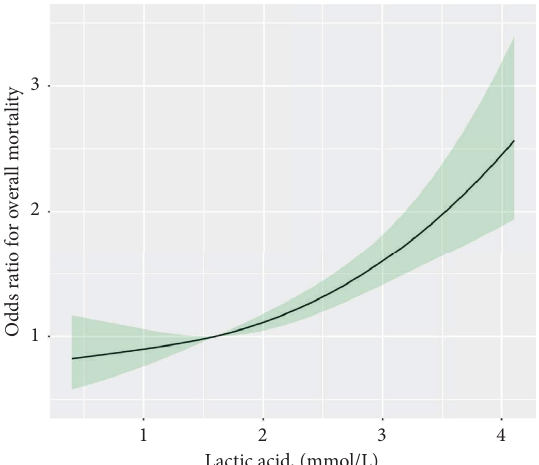
Figure 2: Restricted cubic spline plots of associations between lactic acid levels and in-hospital all-cause mortality. Note: Analyses were adjusted for age, ethnicity, body mass index, weight, systolic blood pressure, the history of atrial fbrillation, liver cirrhosis, acute myocardial infarction, chronic kidney disease, respiratory failure, chronic obstructive pulmonary disease, ventricular fbrillation, diabetes mellitus, septicaemia, serum anion gap, bicarbonate, blood urea nitrogen, calcium, serum creatinine, glucose, hematocrit, hemoglobin, platelet, red blood cells, C reactive protein, length of stay, albumin, white blood cells, N terminal pro B type natriuretic peptide, cardiotonic drugs, nitroglycerin drugs, furosemide drugs, infection-fghting drugs, simplifed Acute Physiology Score II, and sequential organ failure as- sessment. Te solid line and dashed line represent the log-transformed odds ratios and corresponding 95% confdence